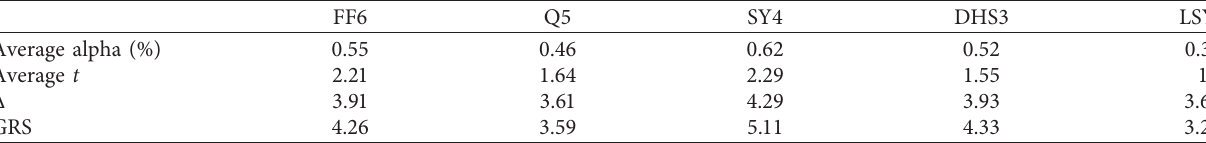
Table 5: Comparison of models in explaining anomalies. This table reports some statistics derived from using various factor models to explain 104 anomalies. We display results of the Fama–French 6-factor model [10], the Hou–Xue–Zhang q5-factor model [2], the Stambaugh–Yuan 4-factor model [21], the Daniel–Hirshleifer–Sun 3-factor model [22], and the Liu–Stambaugh–Yuan 4-factor model [15], in columns “FF6,” “Q5,” “SY4,” “DHS3,” and “LSY4,” respectively. Average alpha and Average t are the absolute mean of alphas and corresponding t -statistics over 104 anomalies. ∆ is the cross-sectional pricing error with respect to each model, which is computed as formula (1). GRS is the statistic of well-known GRS test proposed by Shanken et al. [24]. FF6